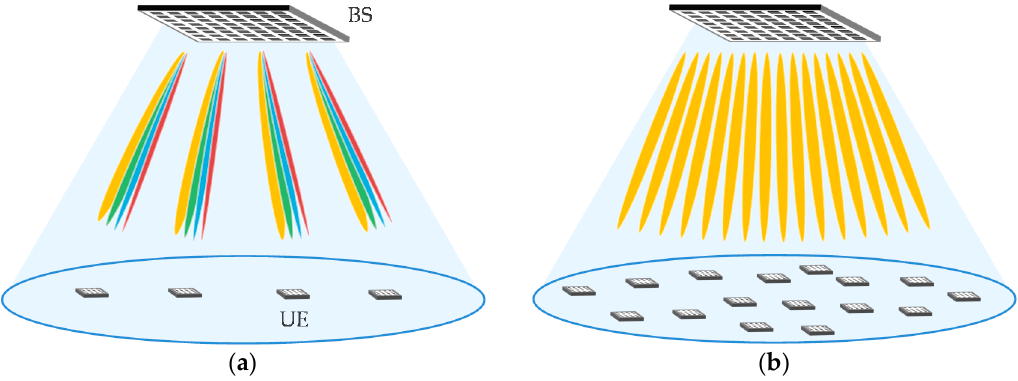
Figure 1. System model: ( a ) Multistream transmission per user equipment (UE): Nu = 4 and Ns = 4; and ( b ) 1st eigenmode transmission per UE: Nu = 16 and Ns = 1.